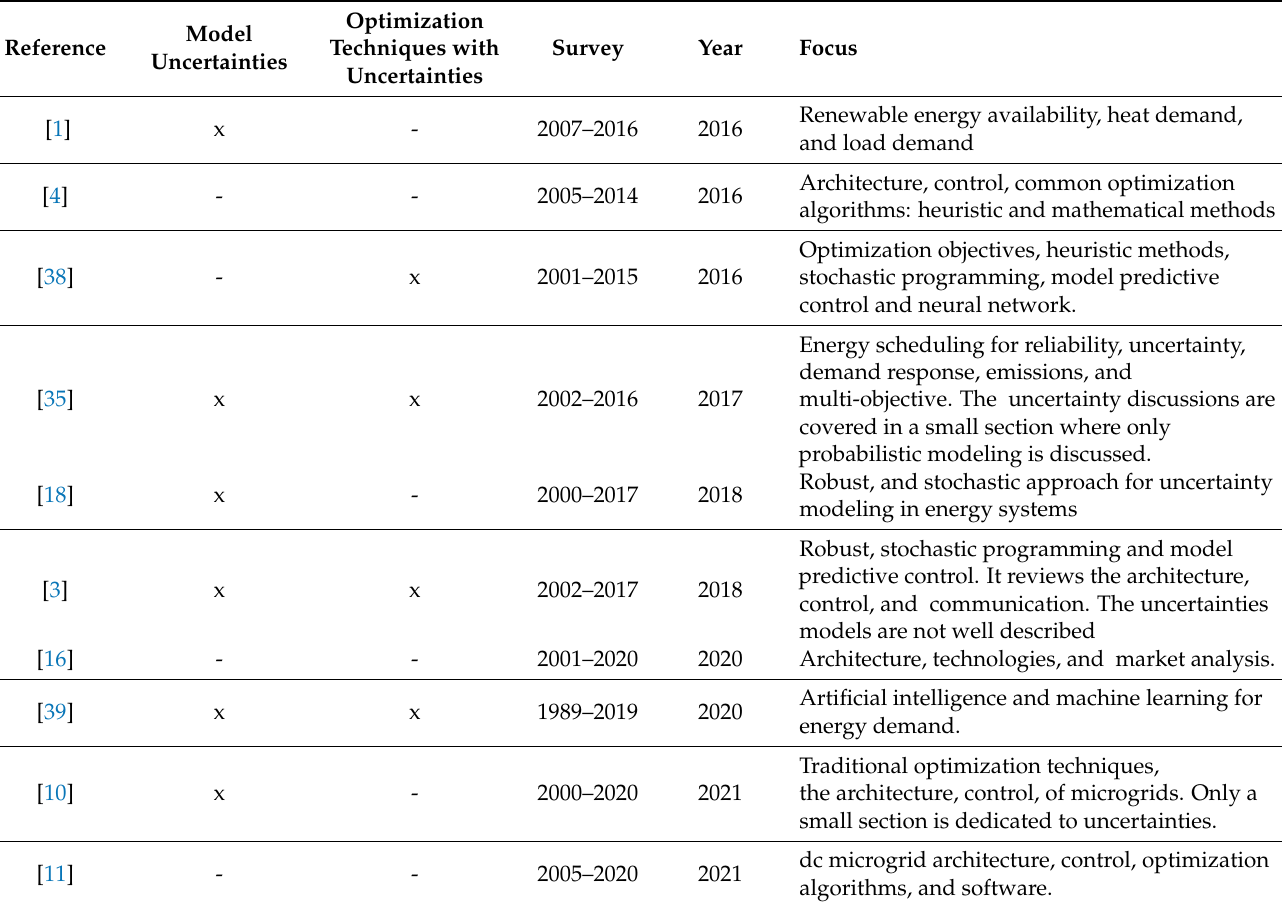
Table 1. An overview of the review papers on EMS for microgrids. The papers are organized by year of publication and whether they cover optimization and modeling when uncertainties are